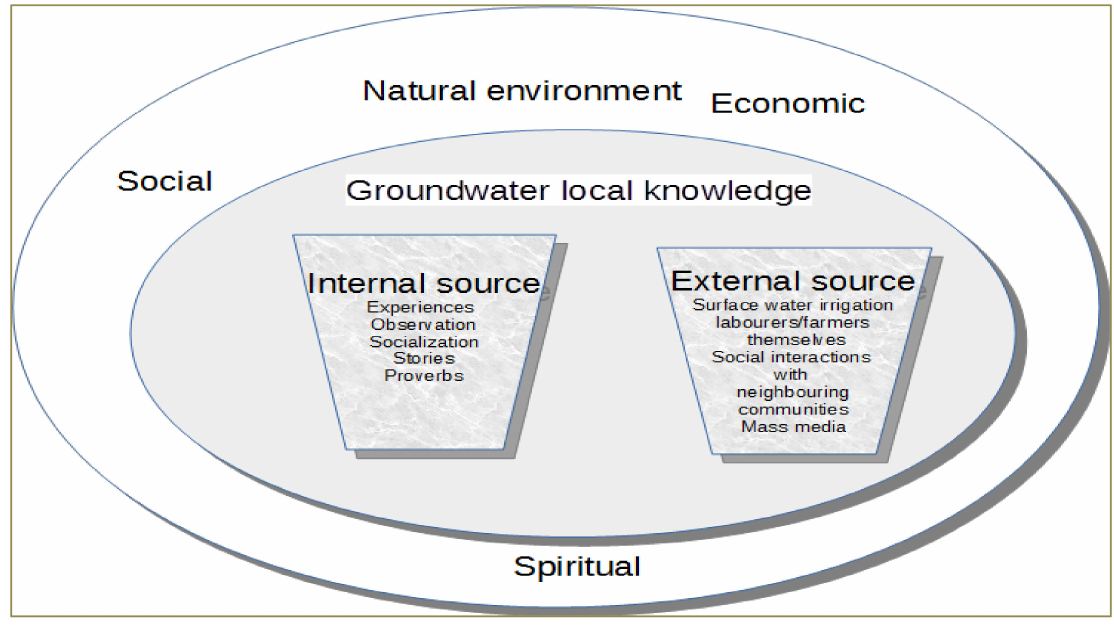
Figure 3. Composition of local